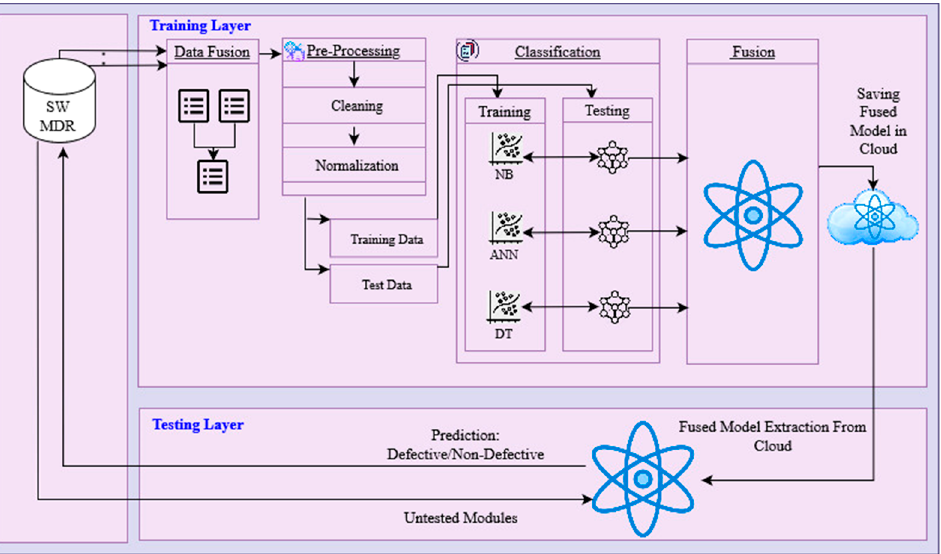
Figure 1. Proposed FSDPS architecture.